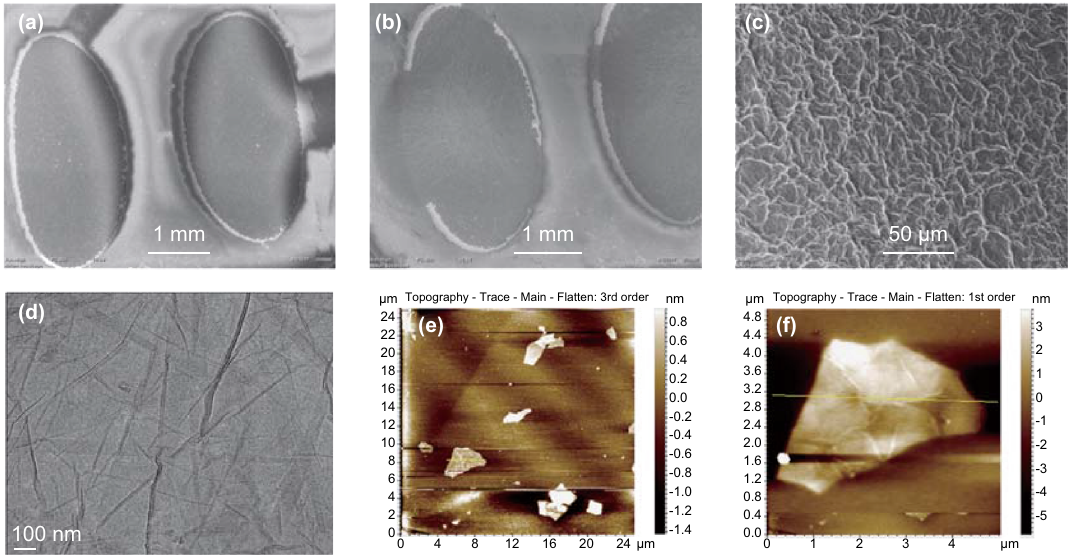
Fig. 5 a SEM analysis of dual SPE before electrodeposition. b SEM analysis of SPE after electroreduction. c High magnification SEM images of electrodeposited e-RGO over the dual SPE. d TEM image of e-RGO. e , f AFM image of micrographs and the corresponding height profiling anal- graphene layers (as shown in Fig. 5e, f), and the corre- ysis manifest * 2 nm in height corresponding to 3–4 sponding line mapping is shown in Fig. S3.